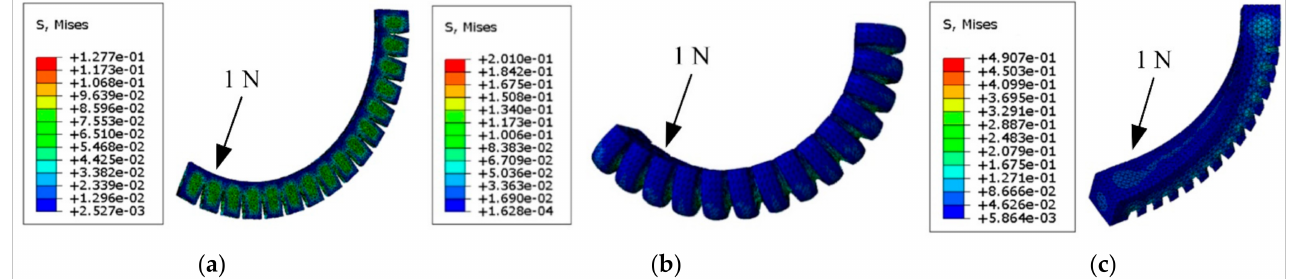
Figure 4. The resultant stress of three kinds of soft manipulators while grasping a sphere: ( a ) step-function type; ( b ) sine-function type; ( c ) ramp-function type.